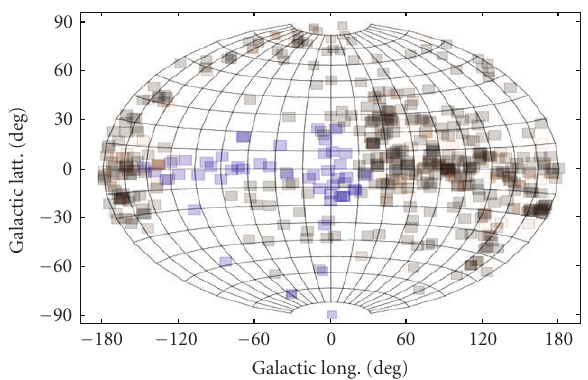
Figure 1: Distribution of Sonneberg Field Patrol Fields and Franklin Adams Fields (blue) in Galactic coordinates. The densely covered fields are